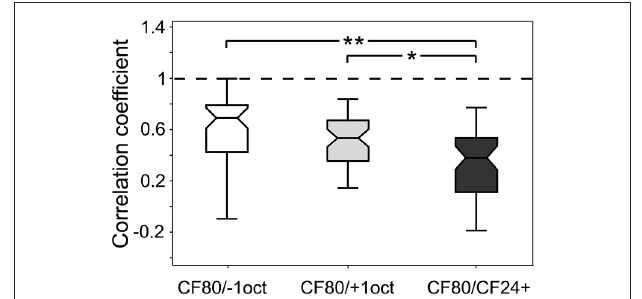
FIGURE 7 | Stimulus-specific correlation of laminar CSD profiles. Boxplots show the correlation coefficient between the laminar profiles of CF80 compared to the remaining stimuli ( − 1oct, +1oct, and CF24+). Boxplot whiskers represent data range, outer edge of box represents second and fourth quartiles of data, and midline represents median of data. Significance was determined using Kruskal-Wallis one-way ANOVA in combination with a multiple comparison post hoc test: ∗ p < 0.05, ∗∗ p <